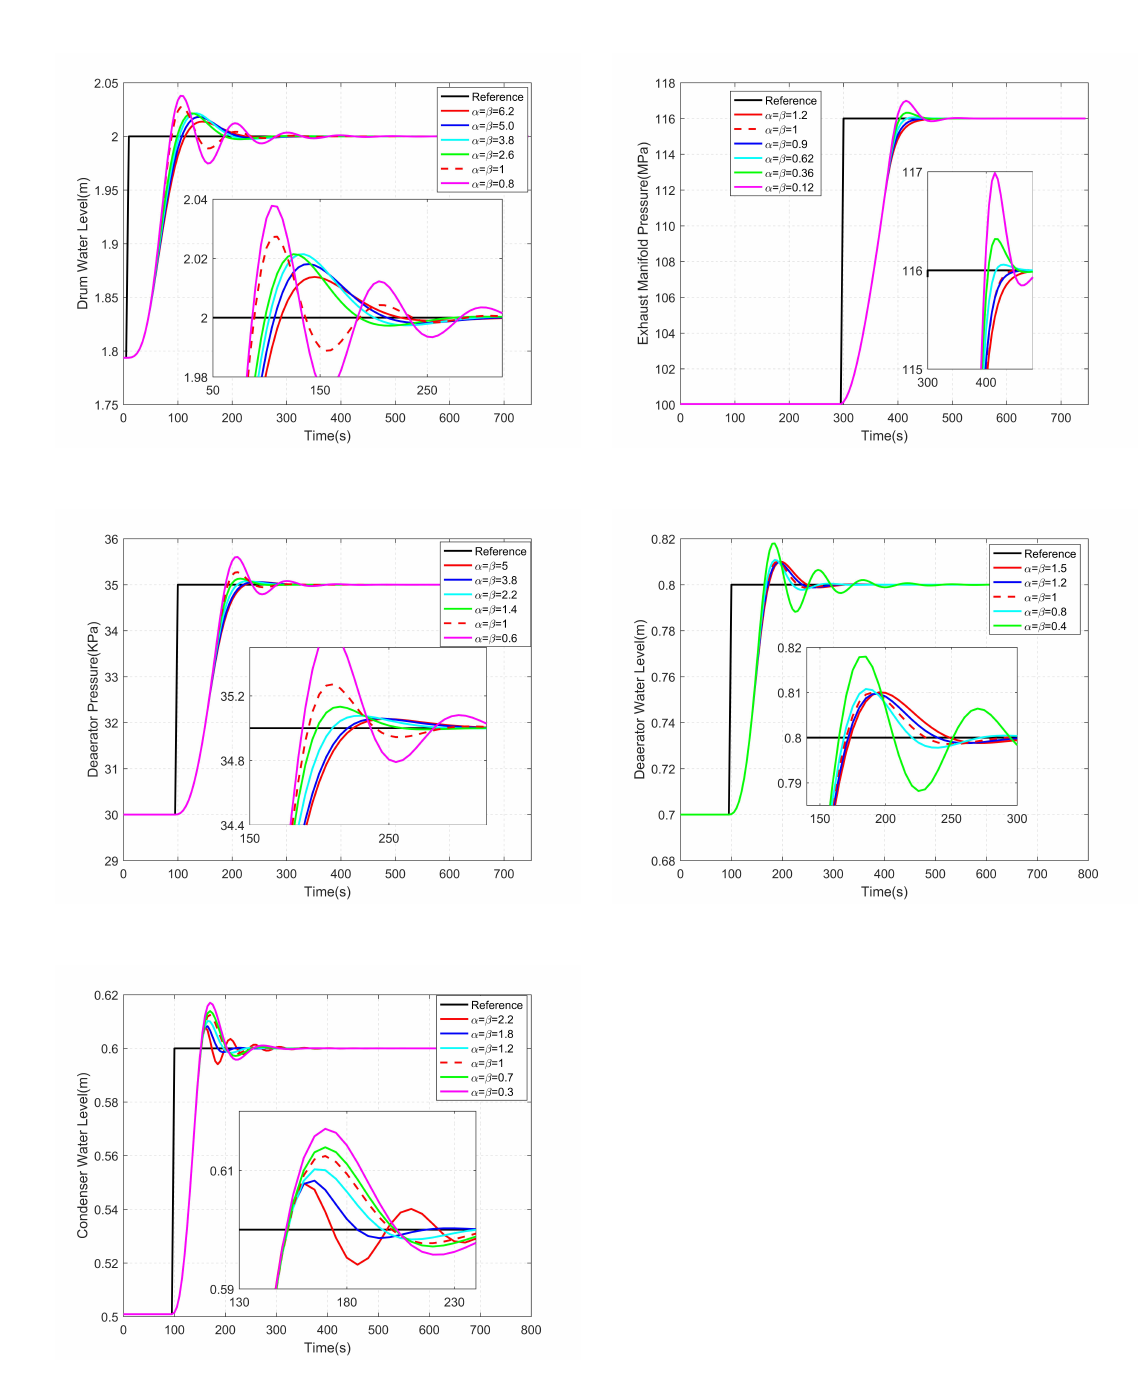
Figure 2. Outputs with different fractional orders for the five